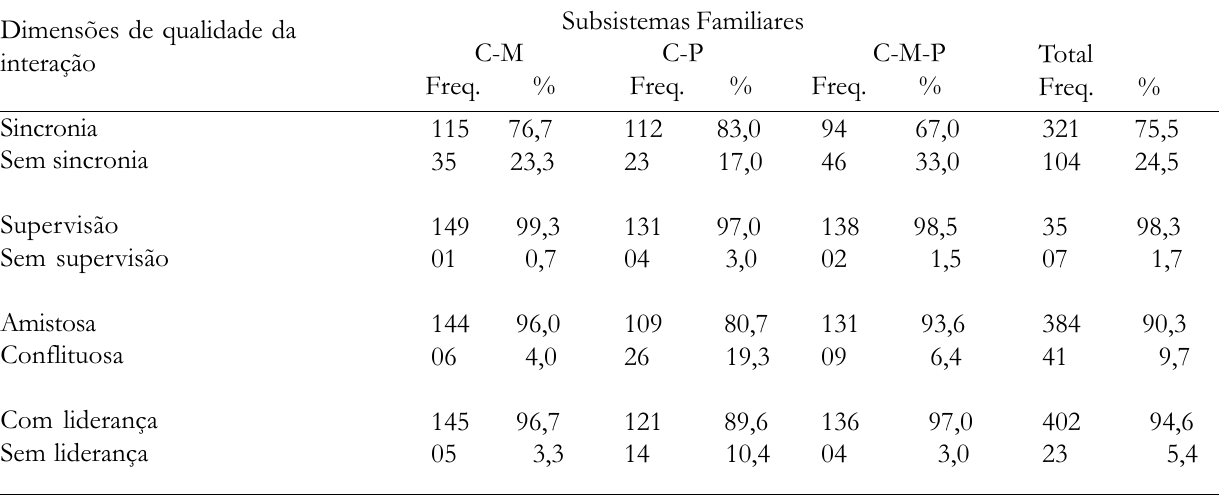
A Figura 3 apresenta os percentuais de cada tipo de (C-M e C-P) e triÆdicas (C-M-P).